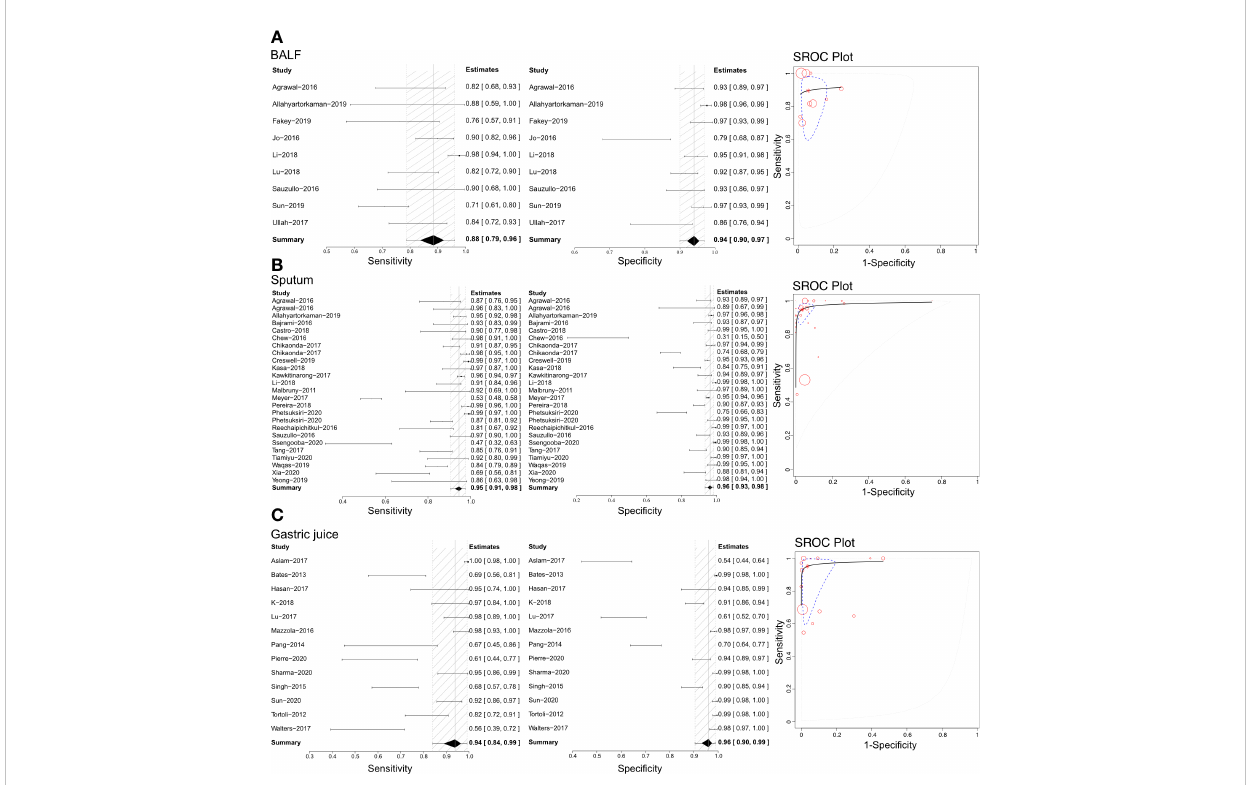
FIGURE 2 The sensitivity, speci fi city and SROC curve of different samples for diagnosing pulmonary TB. (A) The diagnostic ef fi ciency on BALF sample based Xpert analysis; (B) The diagnostic ef fi ciency on sputum sample based Xpert analysis; (C) The diagnostic ef fi ciency on gastric juice sample based Xpert